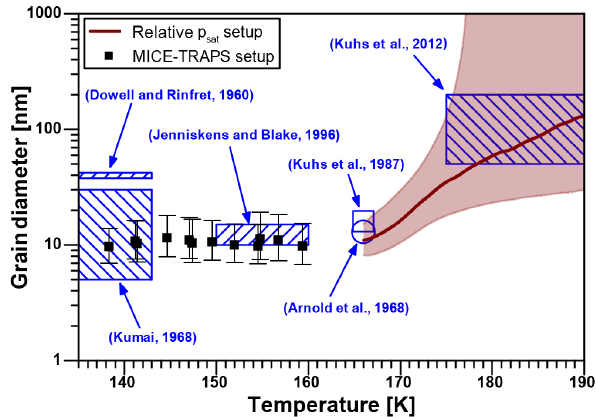
Figure 3. Calculated nano-crystallite diameters as a function of temperature in ice crystallized from ASW. The black squares ( (cid:4) ) represent the results of the MICE–TRAPS measurements and the brown curve with shaded confidence interval the results of the rela- tive vapor pressure measurements. The results are compared to crys- tal diameters reported in the literature (blue shaded areas and